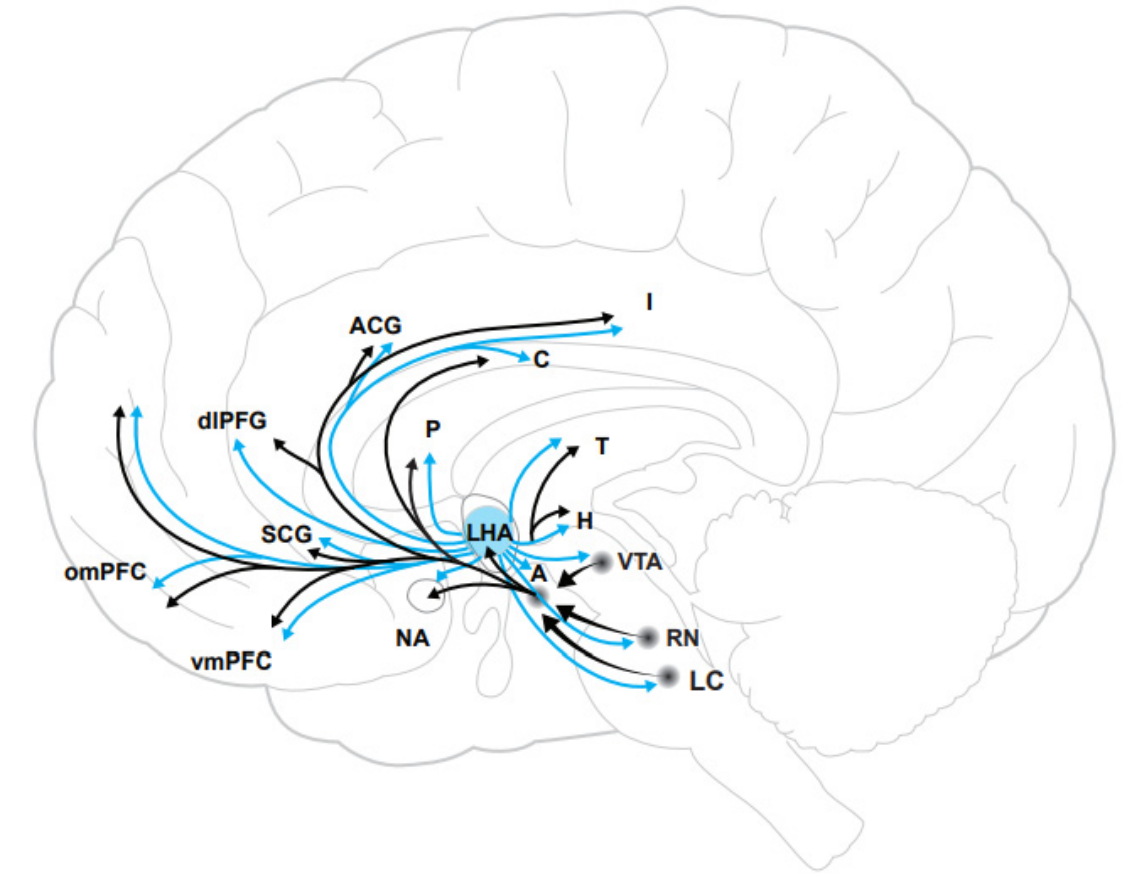
Figure 1. A schematic diagram showing the overlap of orexin projections with hypothesized regions contributing to modulation of hedonic tone. Orexin neurons are shown in blue. Abbreviations: A, amygdala; ACG, anterior cingulate cortex; C, caudate; DLPFG, dorsolateral prefrontal cortex; H, habenula; I, insula; LC, locus coeruleus; LHA = lateral hypothalamus; NA, nucleus accumbens; OMPFC, orbitomedial prefrontal cortex; P, putamen; RN, raphe nucleus; SCG, subgenual cingulate cortex; T, thalamus; VTA, ventral tegmental area; and VMPFC, ventromedial prefrontal cortex.